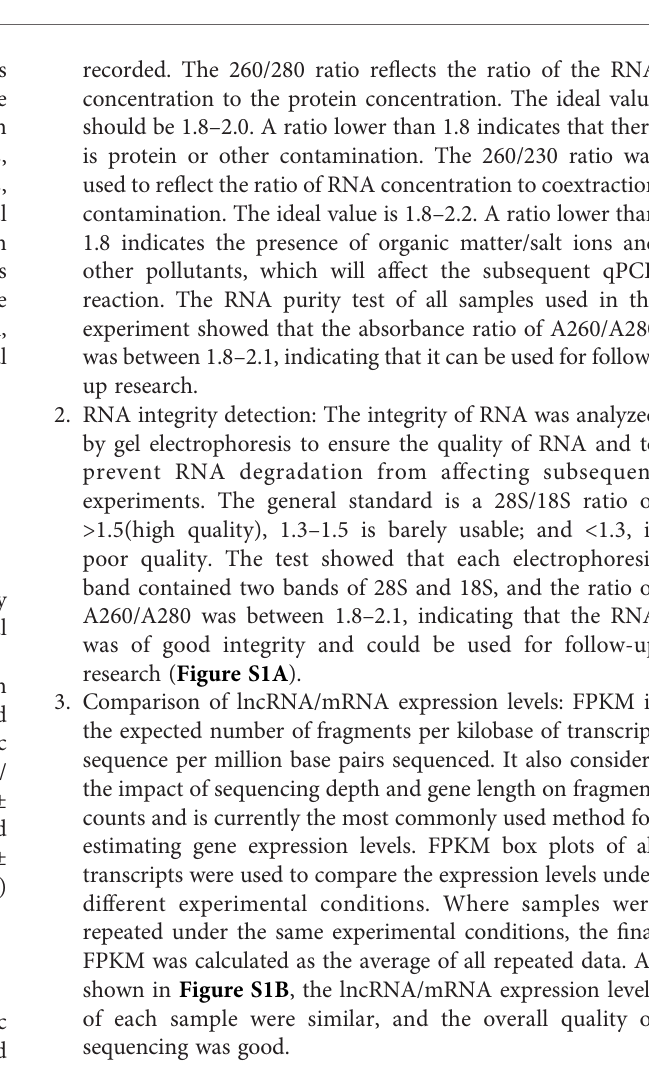
TABLE 3 | Comparison of the general situation of the two groups. General situation